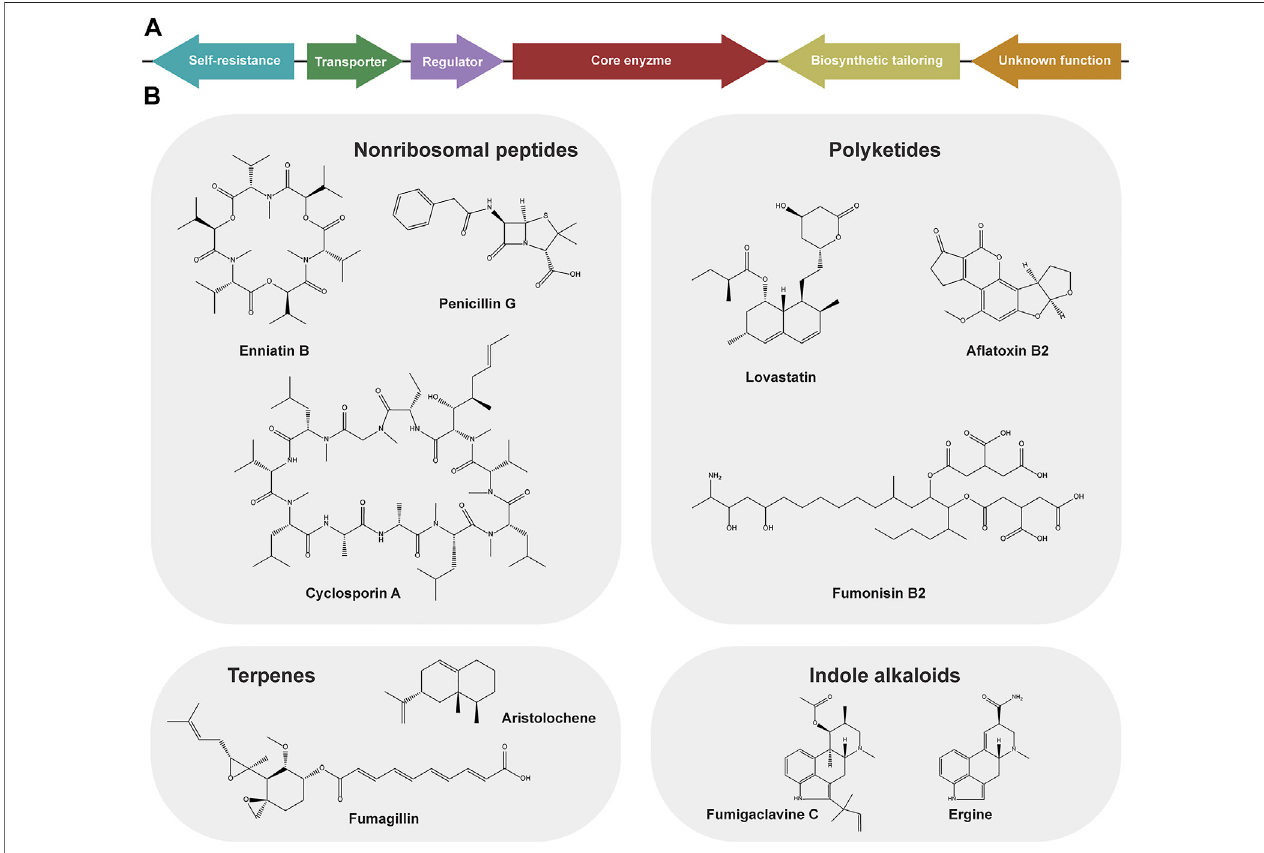
FIGURE1| Schematicrepresentationofafungalbiosyntheticgenecluster(BGCs) (A) andstructurallydifferent,representativemembersofnonribosomalpeptides synthetase (NRPS), and polyketides synthase (PKS), terpenes synthase produced secondary metabolites and indole alkaloids from fungi (B) .